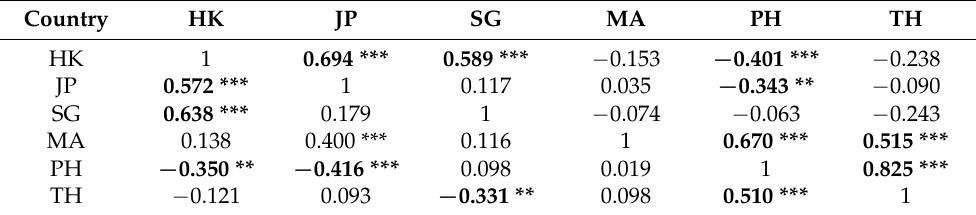
Table 7. Correlations of first local P/NAV factors of each market: 2004Q1 to 2014Q4.